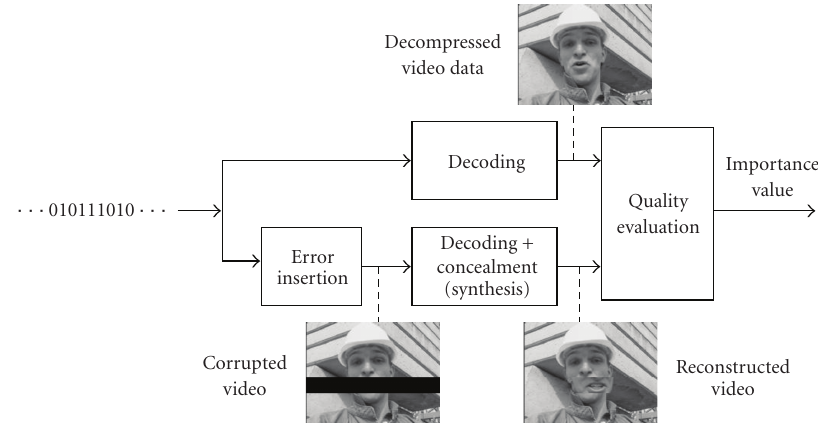
Figure 1: Conceptual scheme of the analysis-by-synthesis technique.